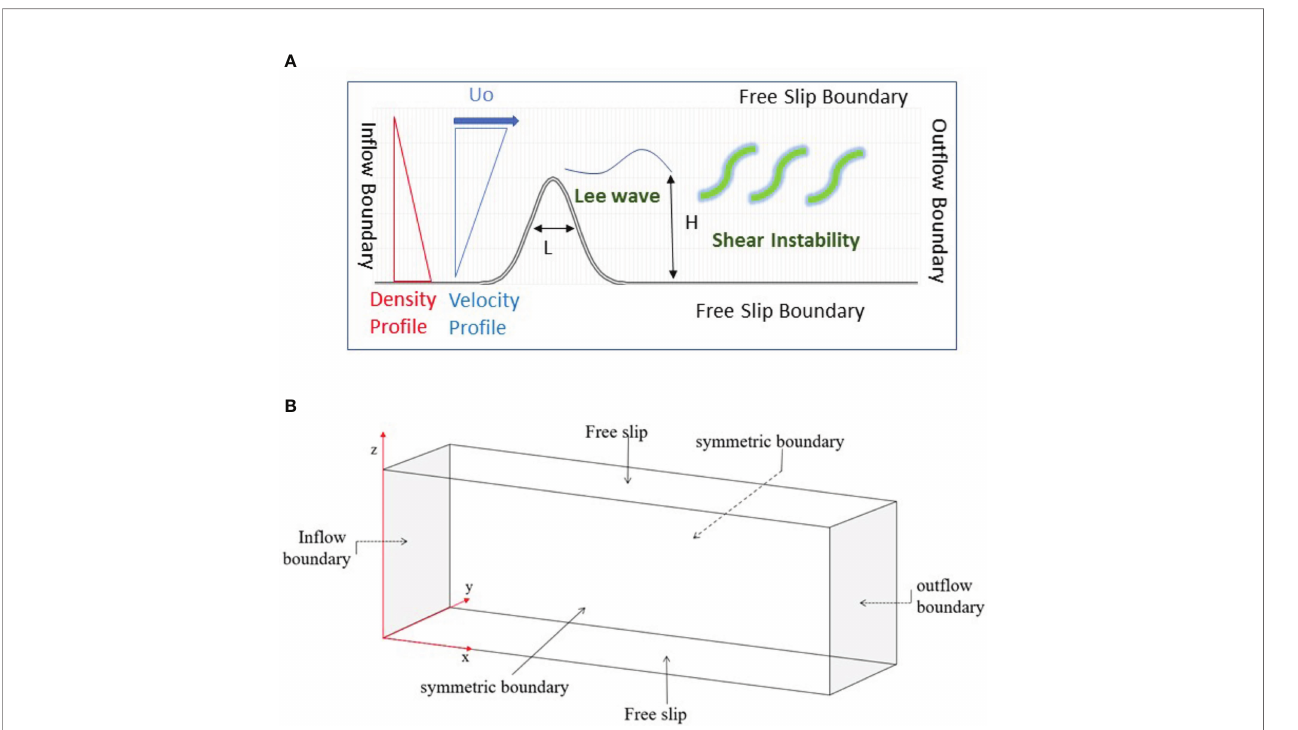
FIGURE 1 | (A) Model setup (B) A sketch of the computational domain. The in fl ow boundary condition implemented at the left and the out fl ow boundary condition at the right. A linear velocity pro fi le is prescribed at the in fl ow boundary with the maximum velocity at the top and the minimum velocity at the bottom with a constant shear rate. Initially, the fl ow is stably strati fi ed with a linear distribution of the density pro fi le. The free-slip boundary condition is used at the top and the